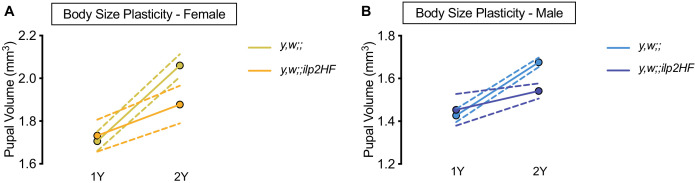
HA- and FLAG-tagged dilp2 transgenic flies exhibit impaired nutrient-dependent body size plasticity.(A) Pupal volume was significantly higher in y,w females and y,w;;ilp2HF females reared on a protein-rich diet (2Y) compared with genotype-matched females cultured on a diet with half the protein (1Y) (p<0.0001 and p=0.0246 respectively; two-way ANOVA followed by Tukey HSD test). The magnitude of the nutrient-dependent increase in pupal volume was higher in y,w females (genotype:diet interaction p=0.001; two-way ANOVA followed by Tukey HSD test). n = 13–36 pupae. (B) Pupal volume was significantly higher in y,w males and y,w;;ilp2HF males reared on 2Y compared with genotype-matched females cultured on 1Y (p<0.0001 and p=0.0354 respectively; two-way ANOVA followed by Tukey HSD test). The magnitude of the nutrient-dependent increase in pupal volume was higher in y,w males (genotype:diet interaction p<0.0001; two-way ANOVA followed by Tukey HSD test). n = 12–46 pupae. For body size plasticity graphs, filled circles indicate mean pupal volume, and dashed lines indicate 95% confidence interval.